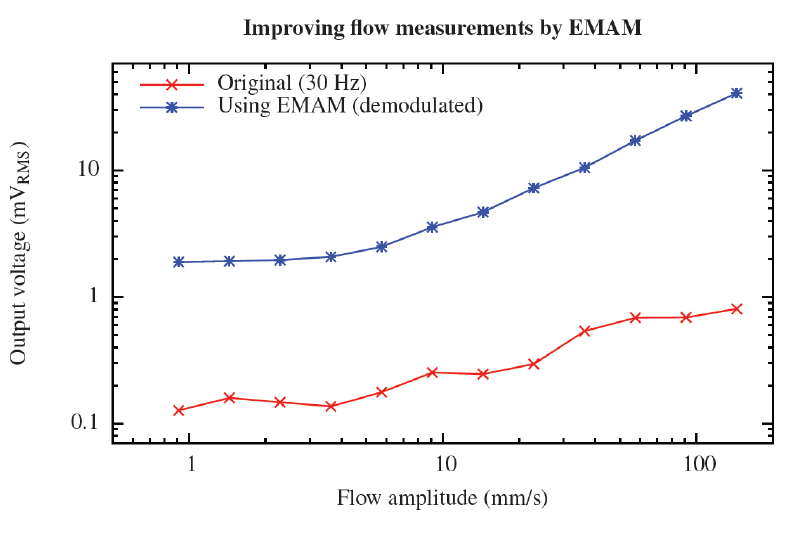
Figure 9. Improvement of the quality of the measured RMS-voltage values at low frequency signals using EMAM. In case of EMAM, a clear linear relationship between flow and output voltage is observed above the system’s noise level (>5